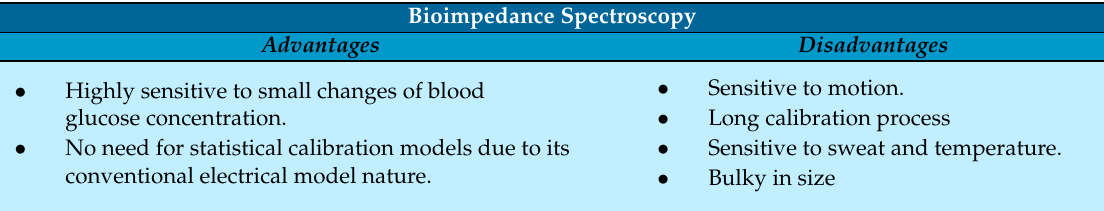
Table 5. Advantages and disadvantages of Surface plasmon